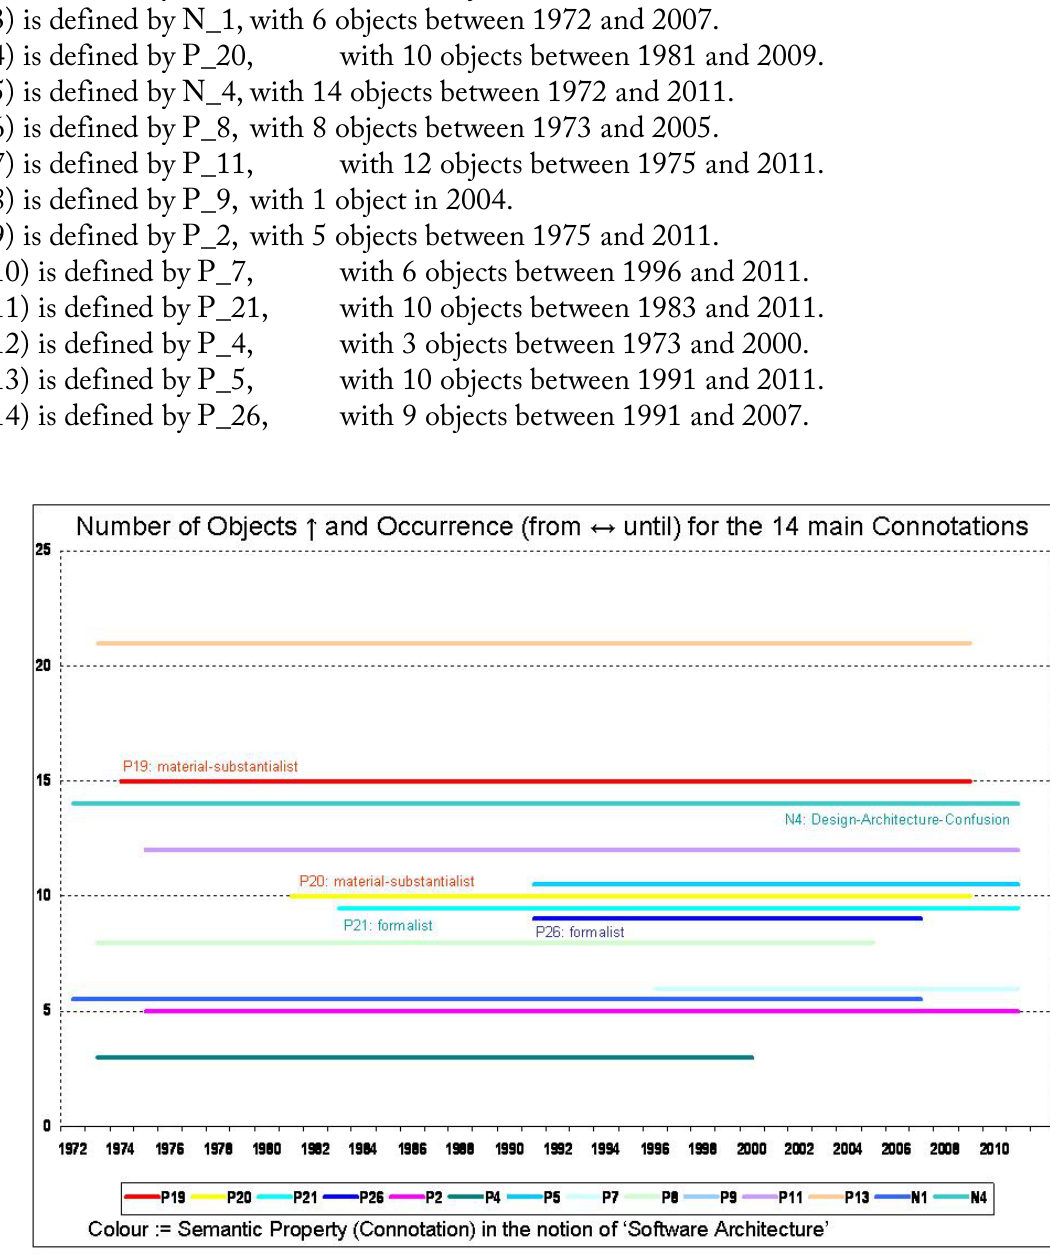
Figure 4. Historic-semantic appearance of the fourteen main connotations in the notion of software architecture, extracted from the formal concept